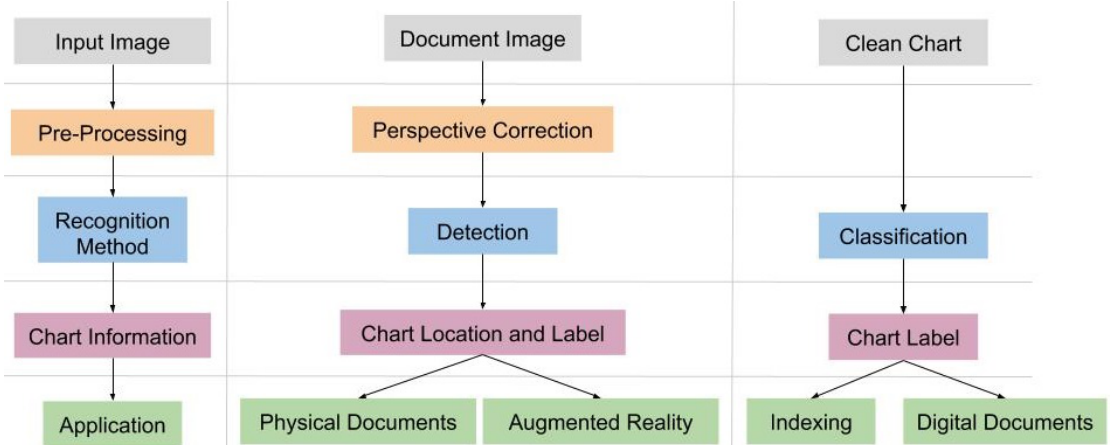
Figure 3. Process for Chart Recognition. Classification is common in literature, but other scenarios can be used if other vision tasks are aggregated. Chart Detection and perspective correction used together can make chart recognition more accurate and usable in new real-world scenarios, like Augmented Reality